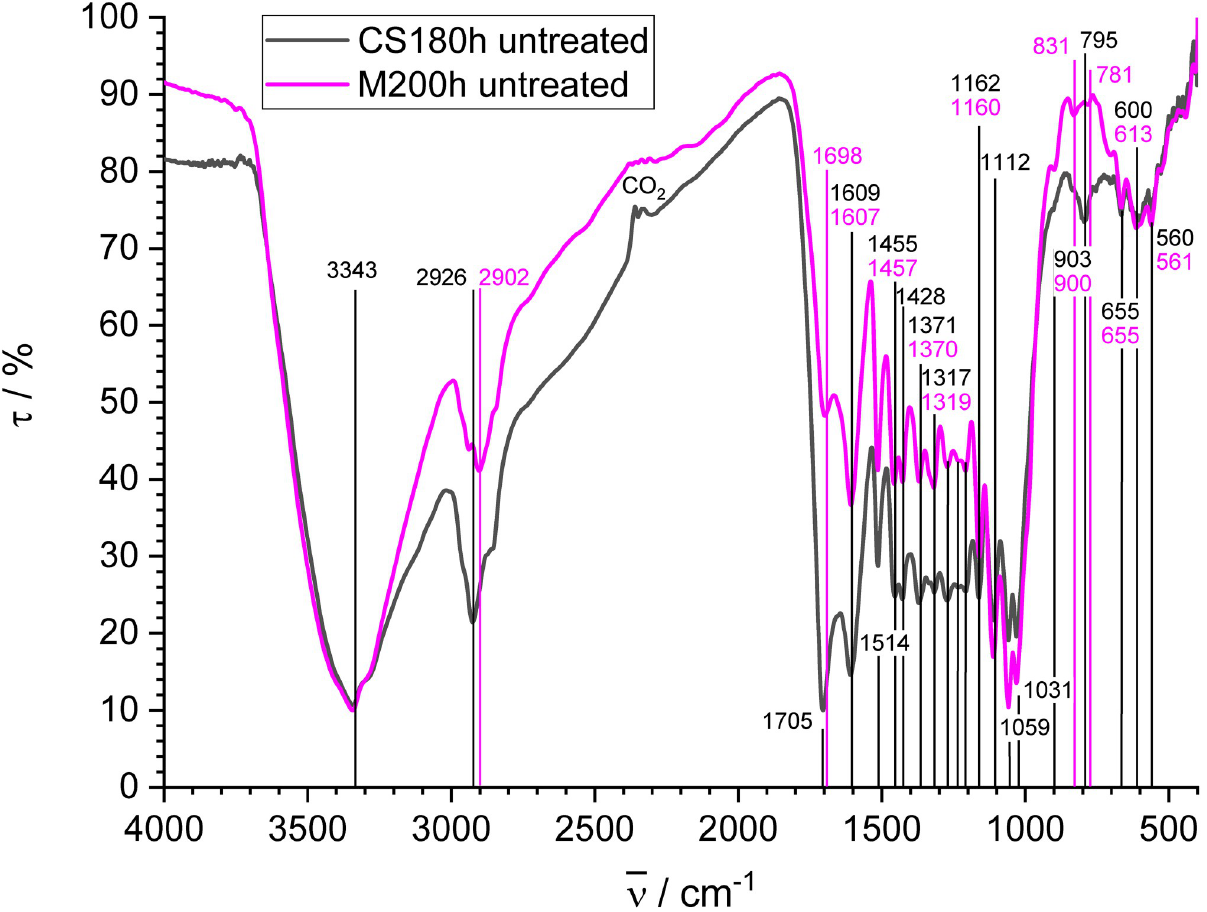
Fig 8. FT-IR spectra of biochars CS180h and M200h.